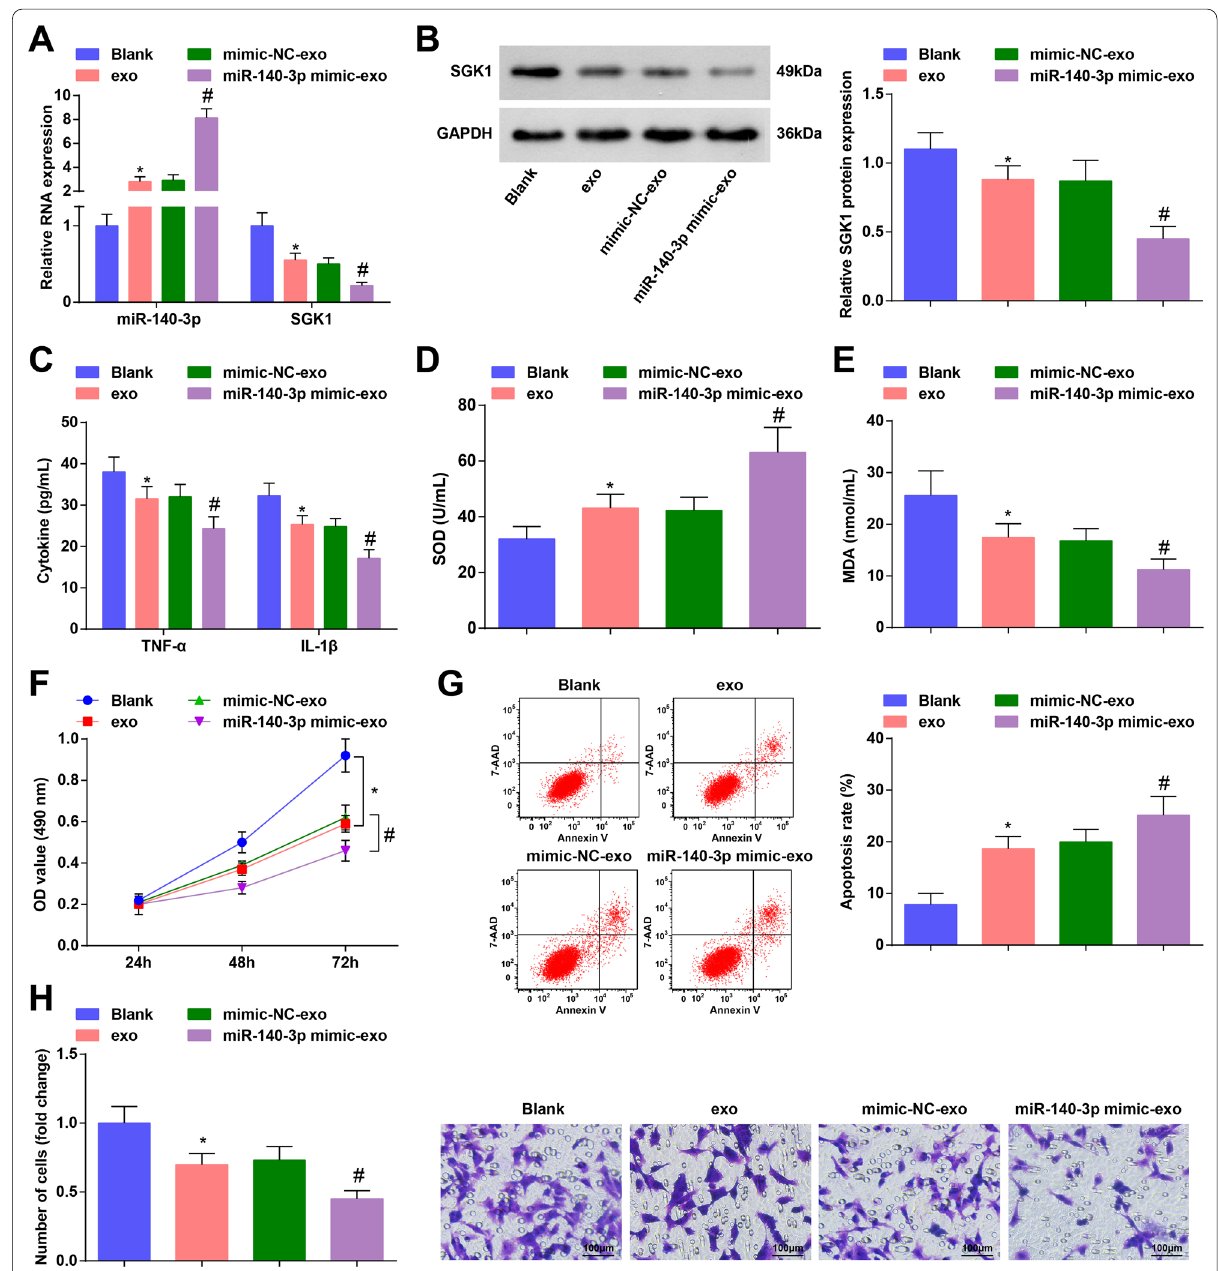
Fig. 4 HUCMSCs-exo or exosomal miR-140-3p decelerates proliferation and accelerates apoptosis of RASFs. A Expression of miR-140-3p and SGK1 in RASFs was detected by RT-qPCR; B Protein expression of SGK1 in RASFs was measured using Western blot analysis; C Contents of TNF-α and IL-1β in RASFs were evaluated by ELISA; D SOD activity in RASFs was measured by ELISA; E MDA content in RASFs was measured by ELISA; F MTT assay was applied to assess the proliferation of RASFs; G Apoptosis of RASFs was detected by flow cytometry; H Migration ability of RASFs was evaluated by Transwell assay; N 3; * P < 0.05 vs the blank group, # P < 0.05 vs the mimic-NC-exo group; the data were expressed as mean = ANOVA was used for comparisons among multiple groups and Tukey’s post hoc test was used for pairwise comparisons after